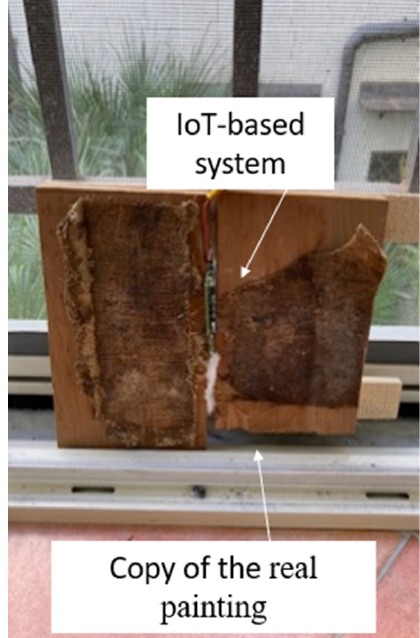
Figure 4. Prototype under test, copy of The Deposition .